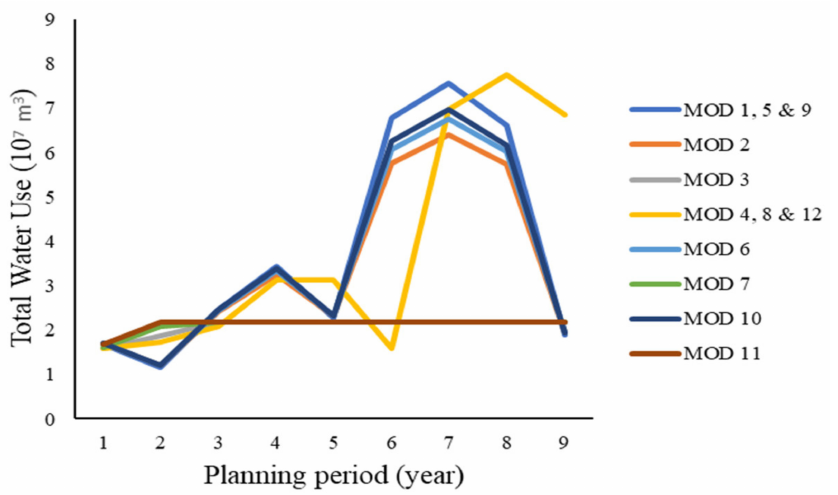
Figure 4. Annual water use by decision scenario.